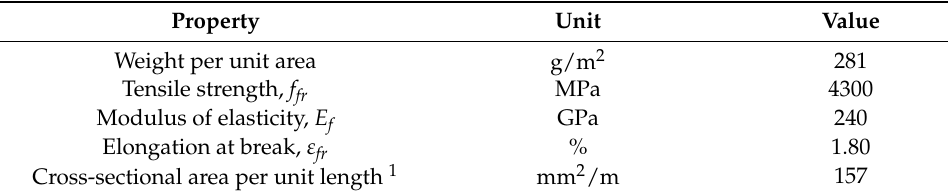
Table 1. Fabric properties (Data from